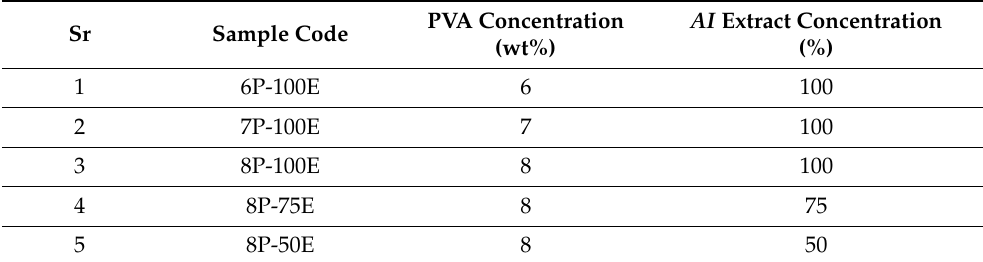
Table 1. Nanofiber membrane samples at different PVA and AI